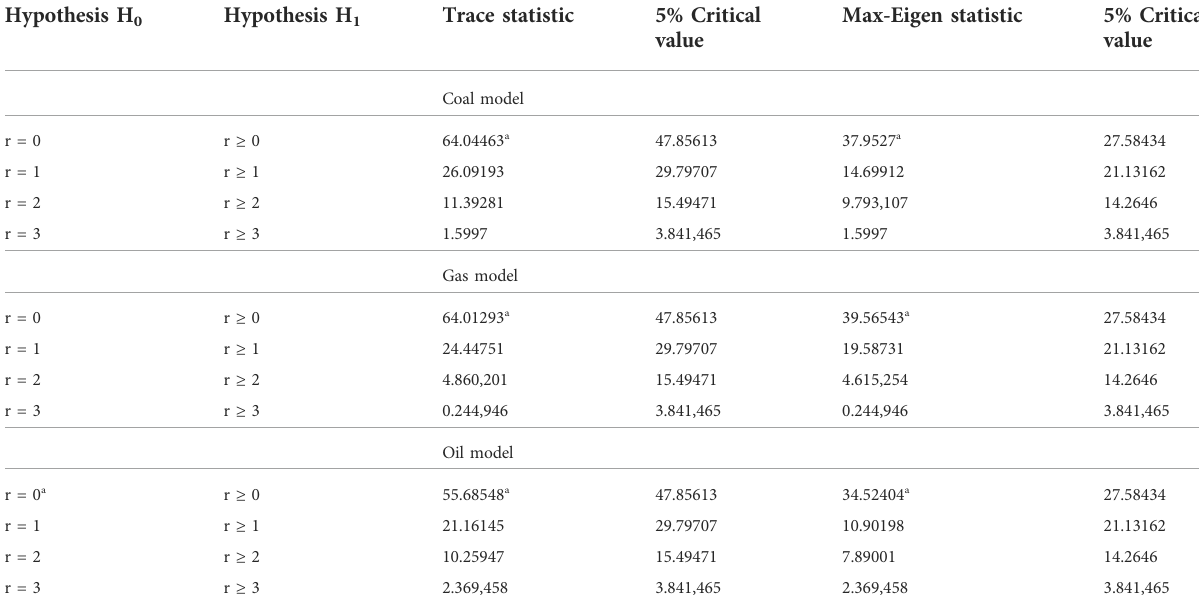
TABLE 3 Results for selection the order of